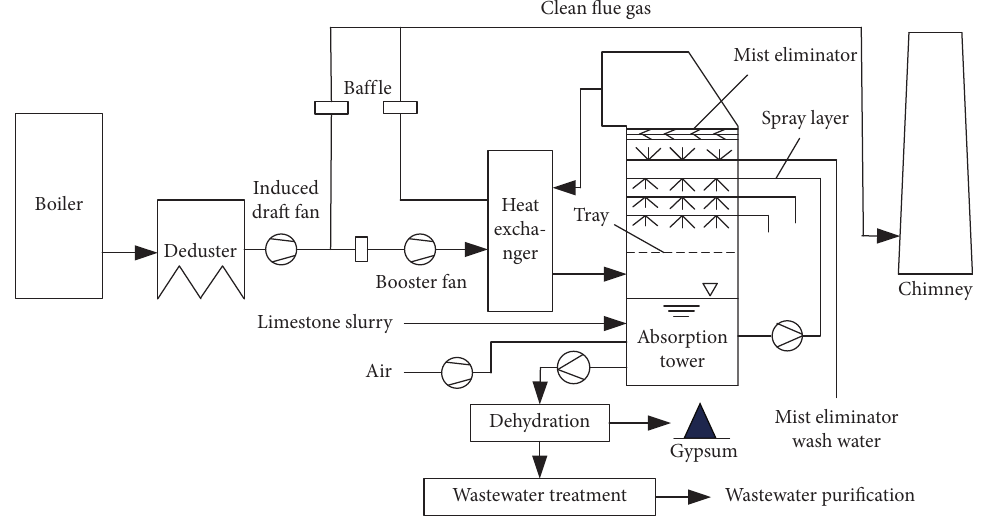
Figure 1: WFGD process